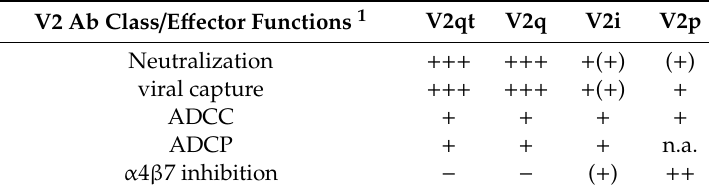
Table 1. Ab e ff ector functions according to V1V2 Ab